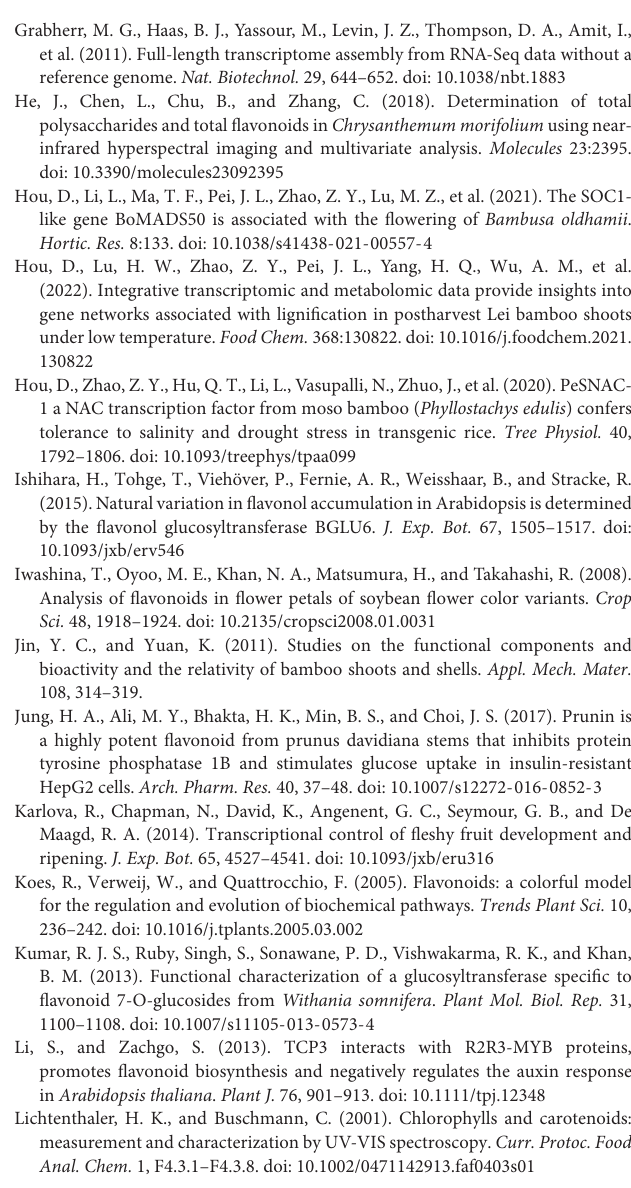
metabolites were identified between positive (A) and negative (B) ionization modes in sulcus and culm of P. violascens . Supplementary Figure 7 | Functional classification of the transcriptome via Gene Ontology (GO) and Eukaryotic Orthologous Group (KOG) analysis. GO (A) and KOG (B) functional annotations in sulcus and culm in P. violascens transcriptome. Supplementary Figure 8 | Determination of differentially expressed genes (DEGs) and metabolites in sulcus and culm. Bubble diagrams of the KEGG enrichment of DEGs between sulcus and culm at the transcript level (A) and differential metabolites between both tissues at the metabolome level (B) . Supplementary Figure 9 | qRT-PCR analysis of PvGL (A) , PvUF7GT (B) , and PvC12RT1 (C) expression between the sulcus and culm. Numbers represent three different repeats of bamboos. Significant differences were determined by one-way ANOVA with Duncan post-hoc test ( p <